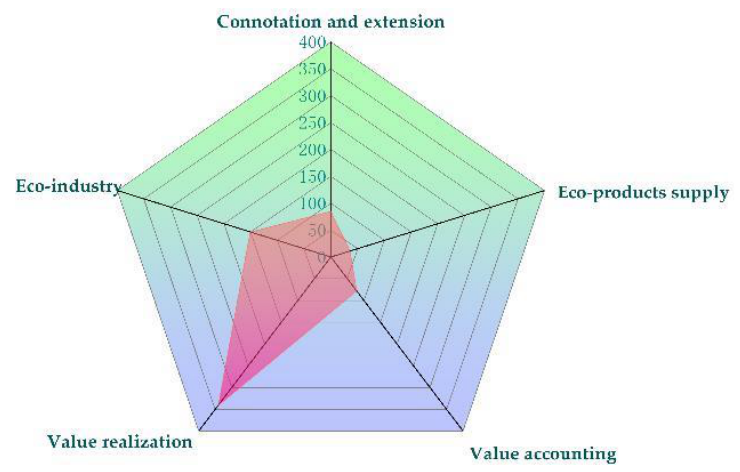
Figure 5. Research content division.